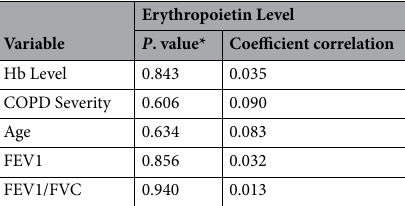
Table 3. Correlation among erythropoietin levels and COPD patients features. *Pearson Correlation for age, Hb levels, FEV1 and FEV1/FVC ratio; Spearman correlation for COPD severity.